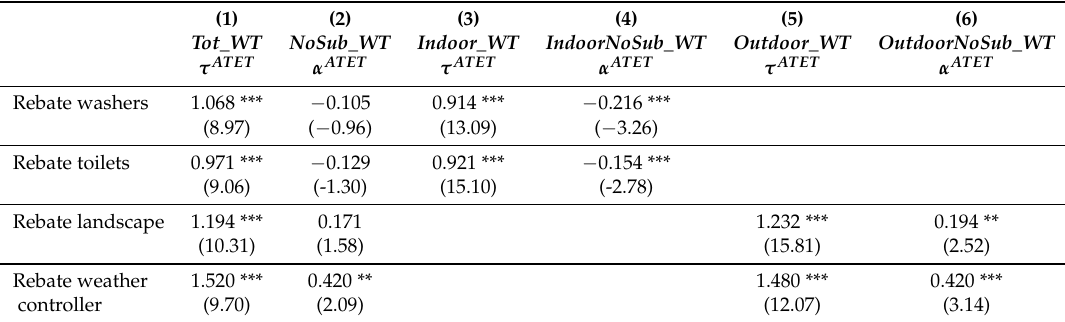
Table 5. Average treatment effects.